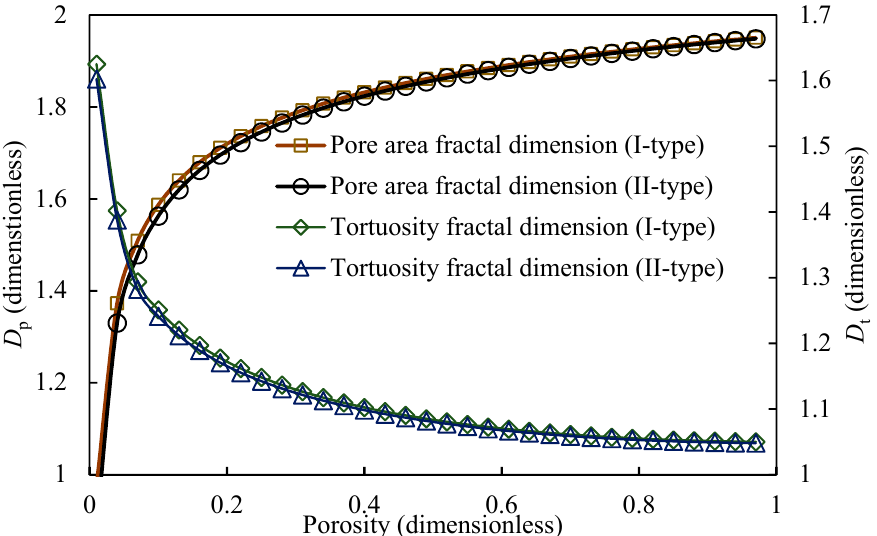
Figure 7. Influence of porosity on the tortuosity fractal dimension ( D t ) and pore area fractal dimension ( D p ) in reservoir rock porous media.